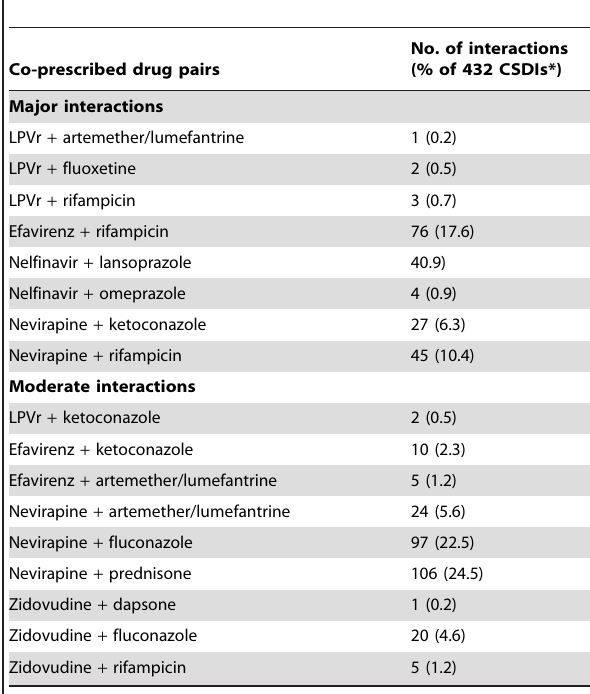
Table 1. Prevalence and Nature of Clinically Significant Drug Interactions in